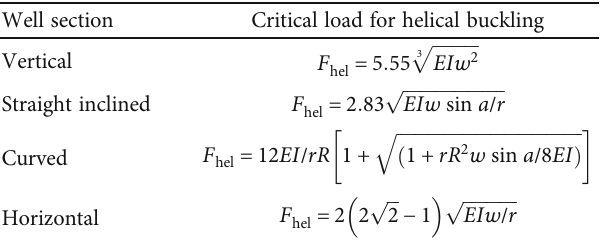
Figure 3: Schematic diagram of beam supports not in a straight line under the combined force. Table 1: Critical load for the helical buckling of the string in di ff erent well sections, where F hel is the critical load of helical buckling (N), r is the borehole annulus clearance (m), and R is the string radius (m).